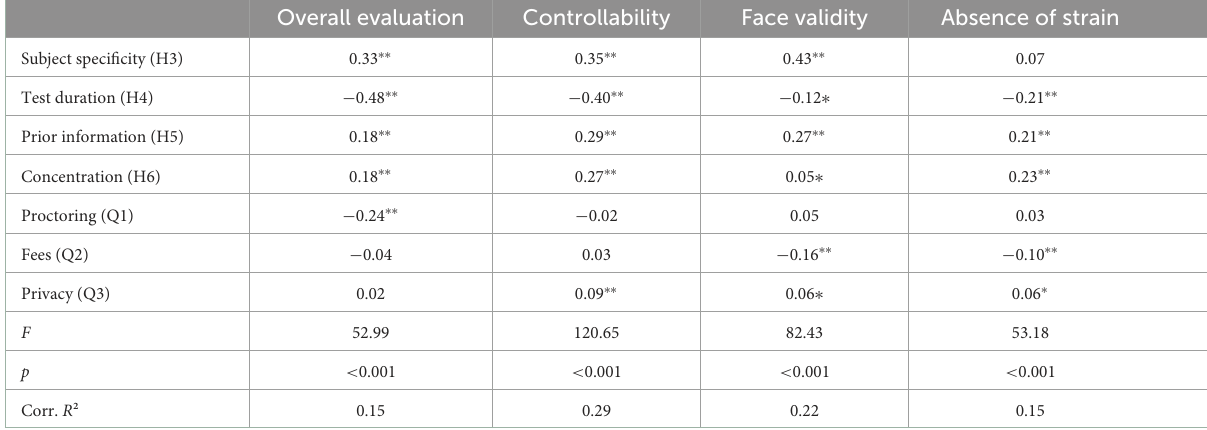
TABLE 6 Standardized regression coefficients for multiple linear regression models with test characteristics as independent variables and Akzept-scales and overall evaluation as dependent variables. Overall evaluation Controllability Face validity Absence of